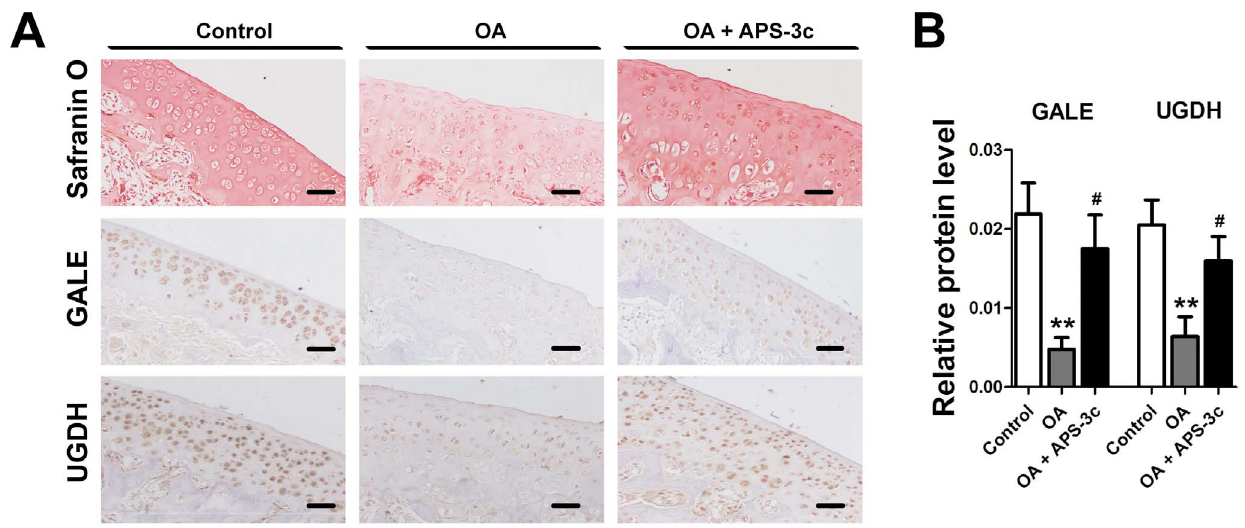
Figure 3. Angelica sinensis polysaccharides (APS-3c) increased protein expression of UDP-sugar synthases invivo . A, Glycosaminoglycan content of rat cartilage from knee joints was detected using Safranin O staining. The protein expression of UDP-galactose-4- epimerase ( GALE ) and UDP-glucose 6-dehydrogenase ( UGDH ) was detected in the cartilage using immunohistochemistry. All the sections were photographed using NIS-Elements software (Nikon, Tokyo, Japan). Scale bars, 100 m m. B, Relative protein level of GALE and UGDH was presented as mean optical density of each chondrocyte. ** P , 0.01 versus control; # P , 0.05, ## P , 0.01 versus osteoarthritis (OA) group.